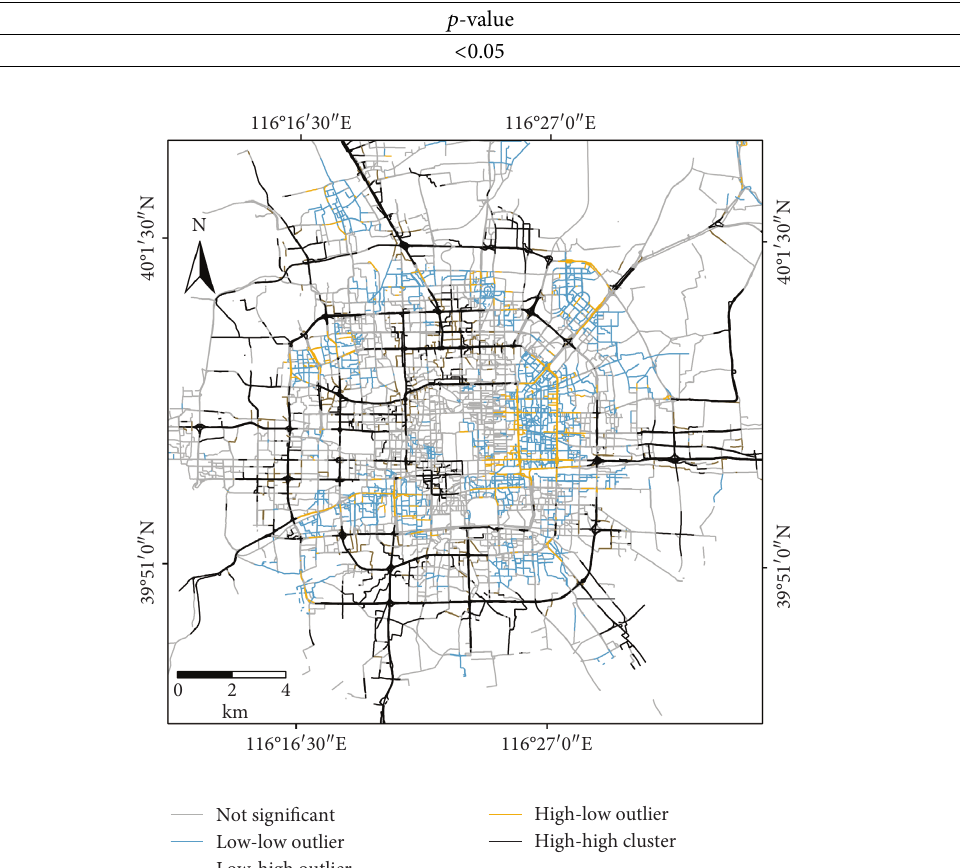
Figure 6: Local spatial autocorrelation analysis of taxi drivers’ local wayfinding performance levels.